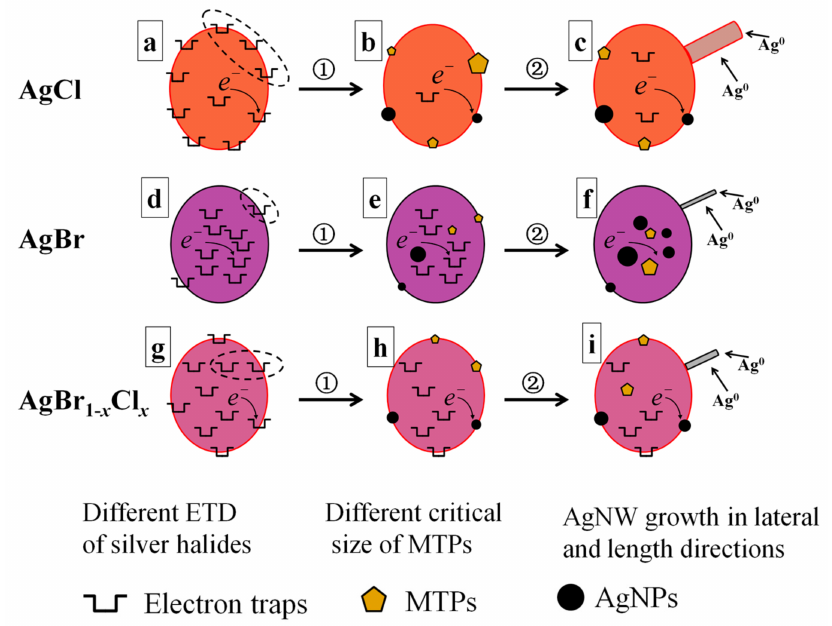
Figure 5. Schematic illustration of the growth of AgNWs undergoing two steps ( 1 (cid:13) , 2 (cid:13) ) for the three types of silver halides of AgCl ( a – c ), AgBr ( d – f ) and AgBr 1 − x Cl x ( g – i )